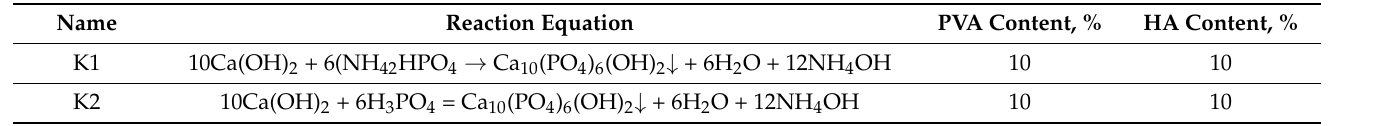
Table 1. Composition of composite materials K1 and